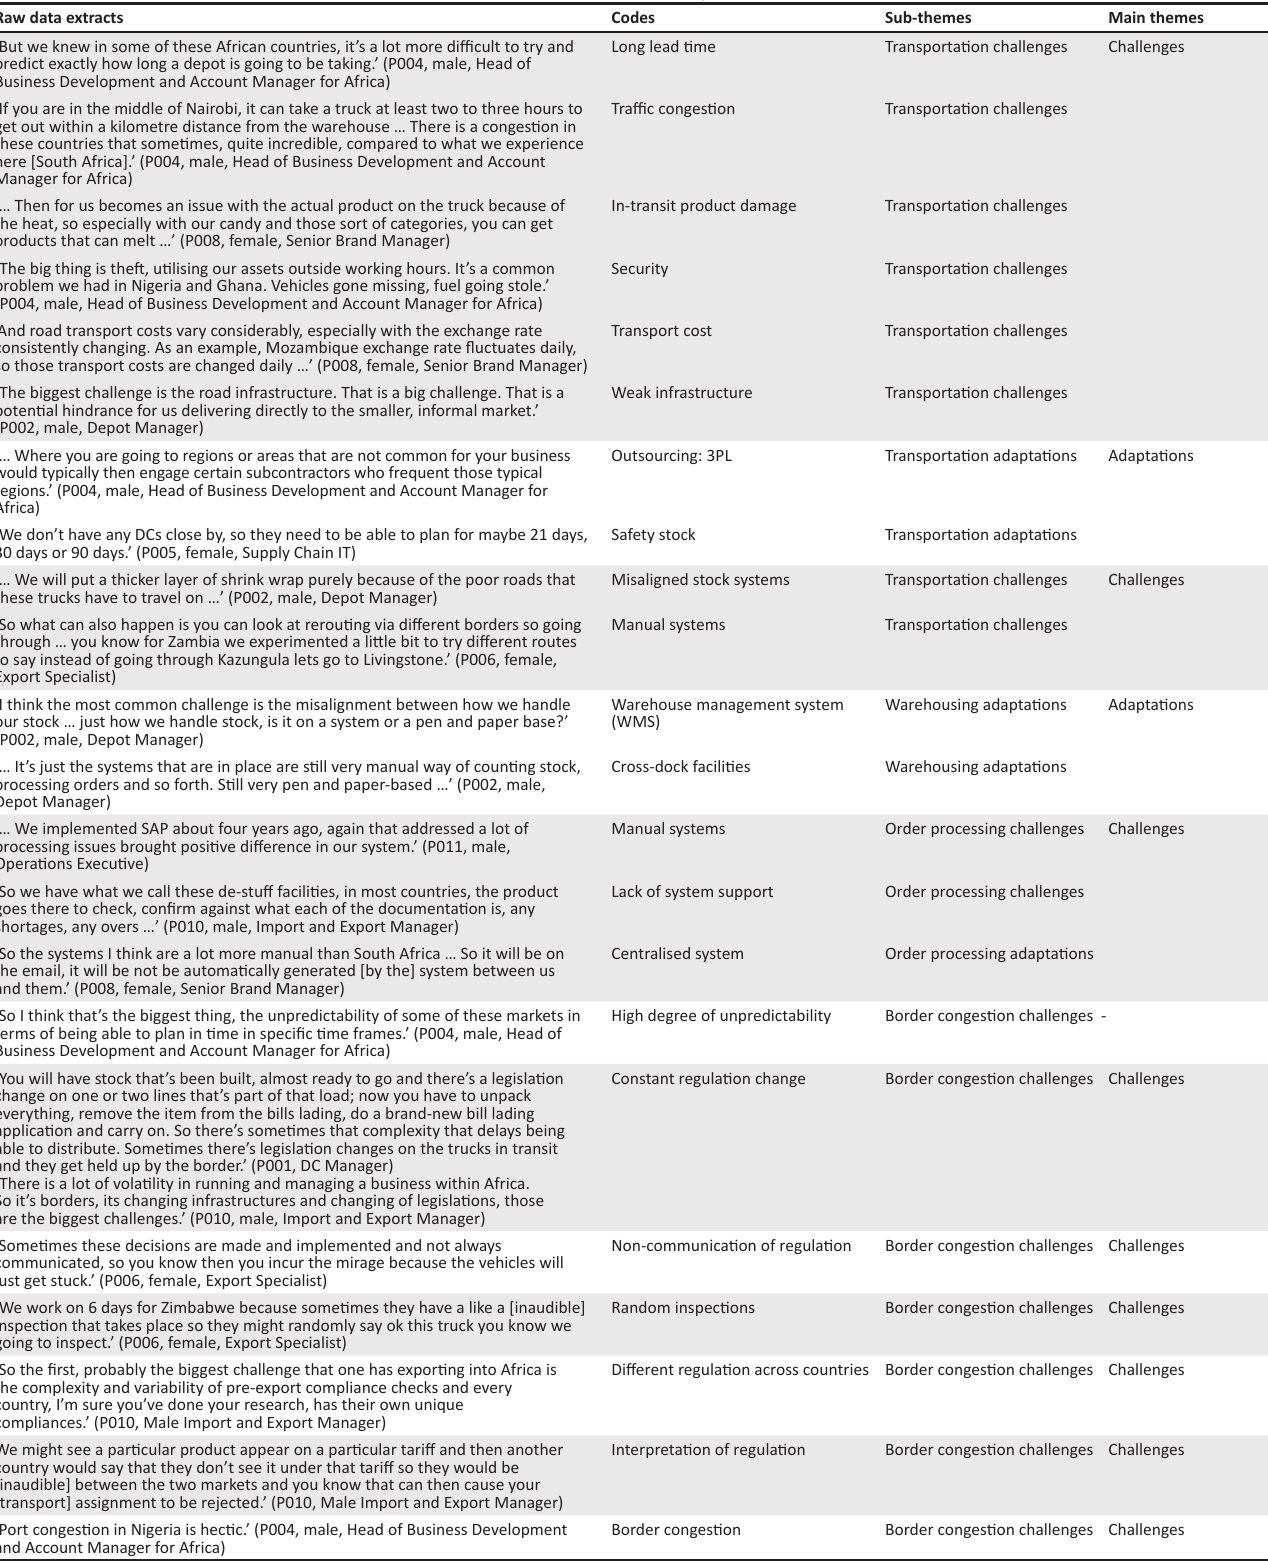
TABLE 1-A1: The link between the codes, sub-themes and main themes identified in this study. Raw data